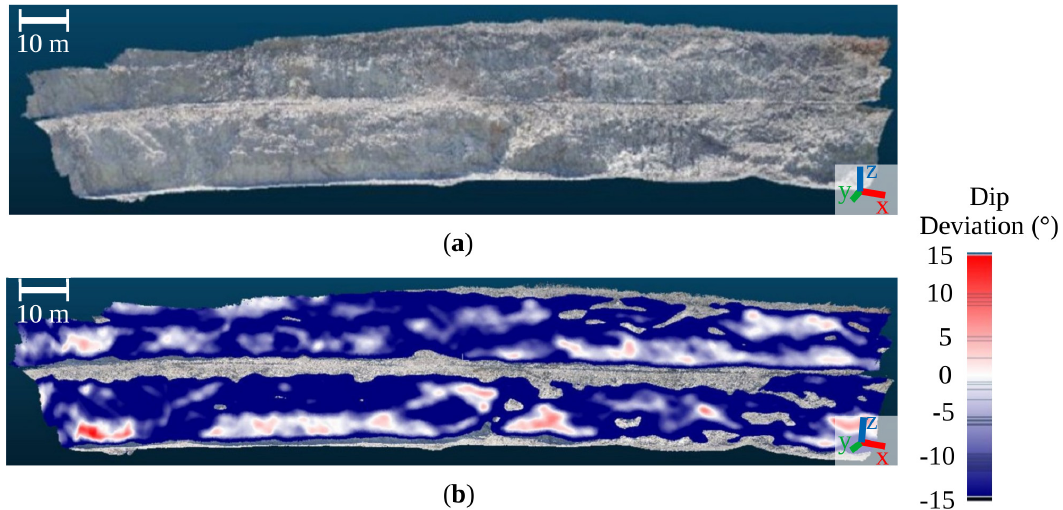
Figure 13. ( a ) Point cloud generated for Mine A and ( b ) the achieved bench face angle compared to the target bench face angle of 75 ◦ , with areas in blue lower, white ± 3 ◦ of the target and red as areas above the